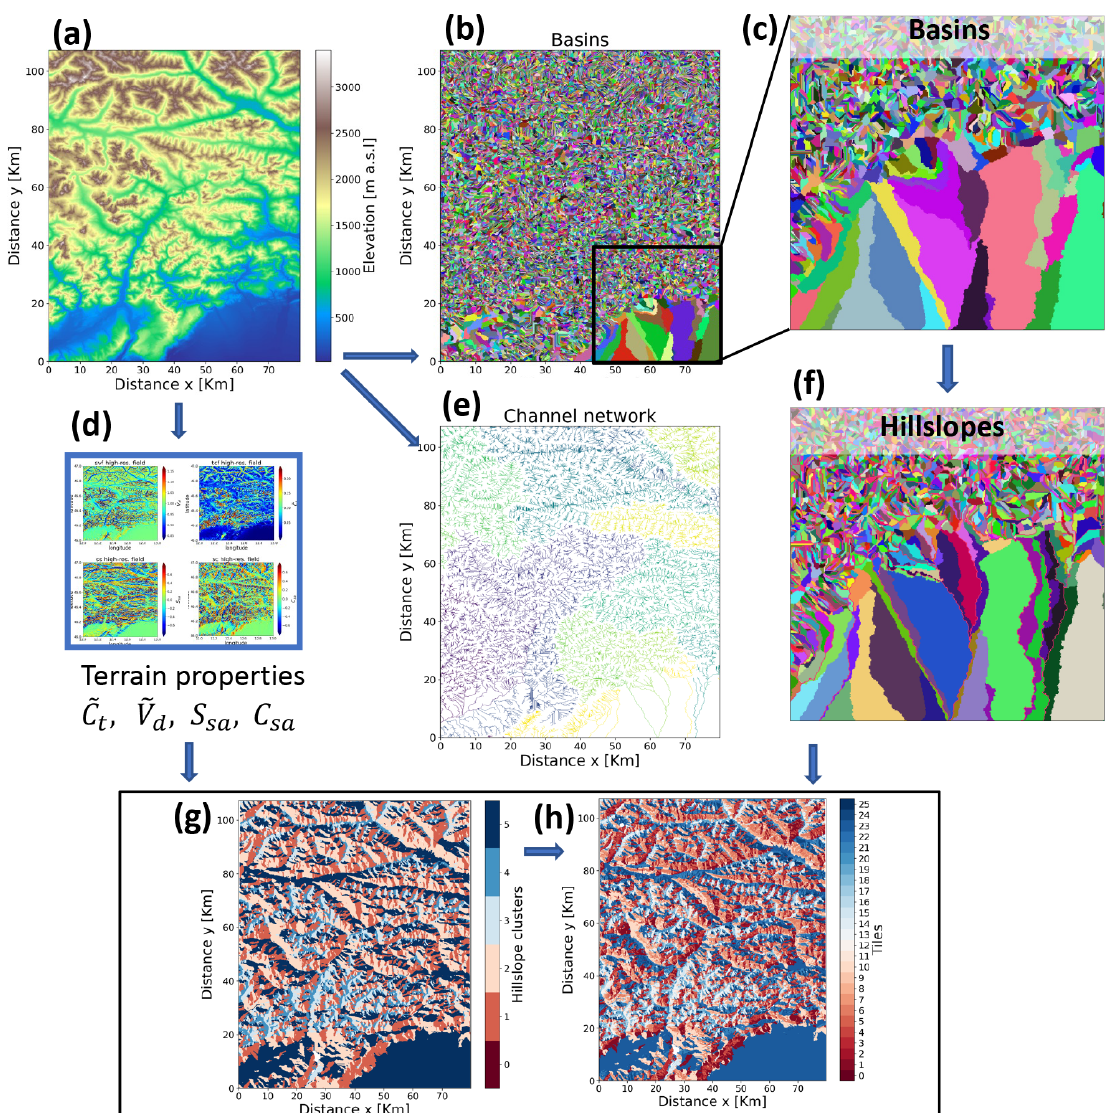
Figure 3. Schematic representation of the land clustering workflow. The land elevation map (a) is used to compute the variables of interest (sky and terrain view factors and functions of terrain slope and aspect, d ) which are then used in the hierarchical clustering steps, yielding a map of homogeneous land units needed to parameterize radiation–topography interactions. The delineation of channel networks (e) , water- sheds (b, c) , and hillslopes (f) follows the approach developed by (Chaney et al., 2018). The resulting spatial distribution of hillslope clusters and land tiles (corresponding to the two stages of land clustering) are shown in (g) and (h) ,